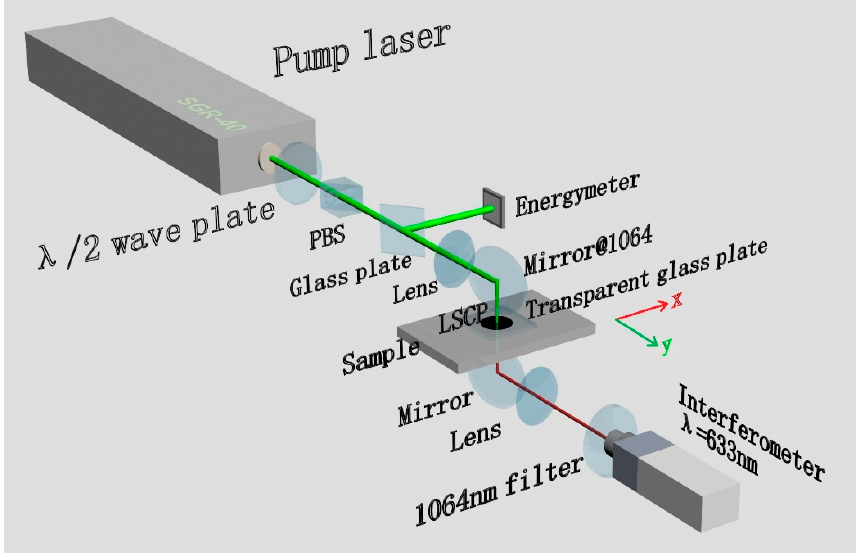
Figure 2. The scheme of the experimental setup.